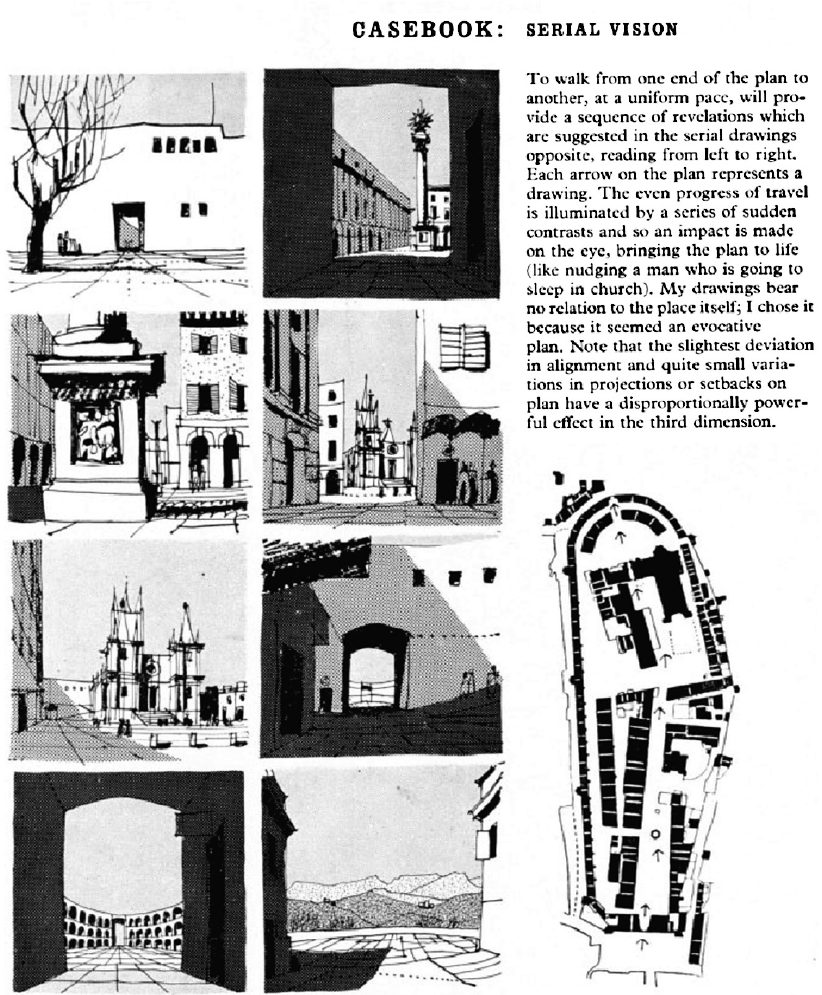
Figure 9. Cullen, “Serial Vision,” the opening page of the Casebook section of Townscape , 1961, reproduced by permission of Taylor & Francis Books,